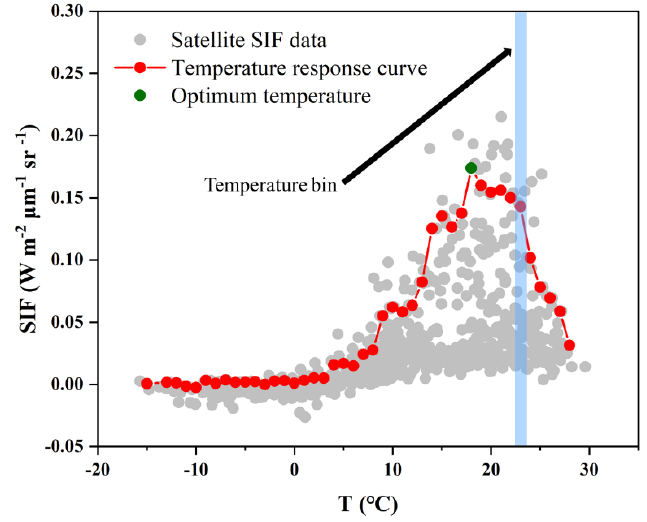
Figure 1. Optimum temperature calculation based on a satellite SIF pixel.